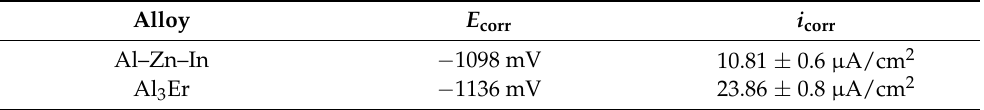
Table 5. Fitting values of polarization curves.